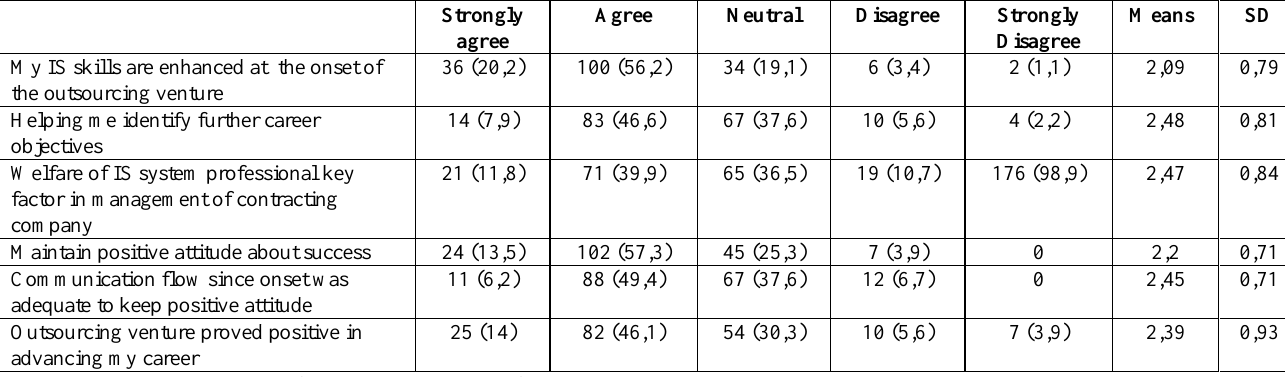
Means SD Disagree 0,84